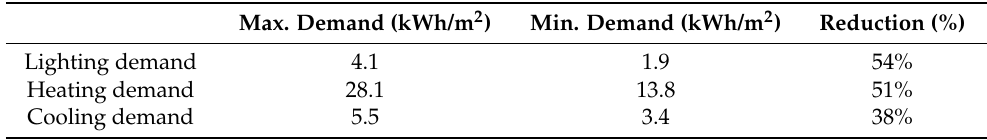
Table 10. The reduction in each energy demand resulted from single-objective optimisations. Max. Demand (kWh/m 2 ) Min. Demand (kWh/m 2 ) Reduction (%) Lighting demand 4.1 1.9 54% Heating demand 28.1 13.8 51% Cooling demand 5.5 3.4